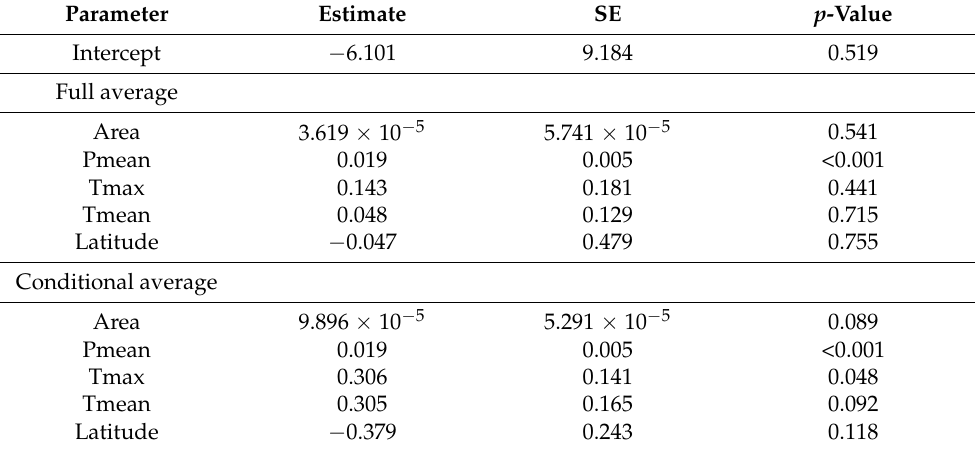
Table 1. Results of multimodel selection for the influence of geographical and climatic variables on earwig species richness in Italy. SE: standard error, Area: surface of region (km 2 ), Pmean: average total annual precipitation (mm), Tmean: average annual temperature ( ◦ C), Tmax: mean maximum temperature ( ◦